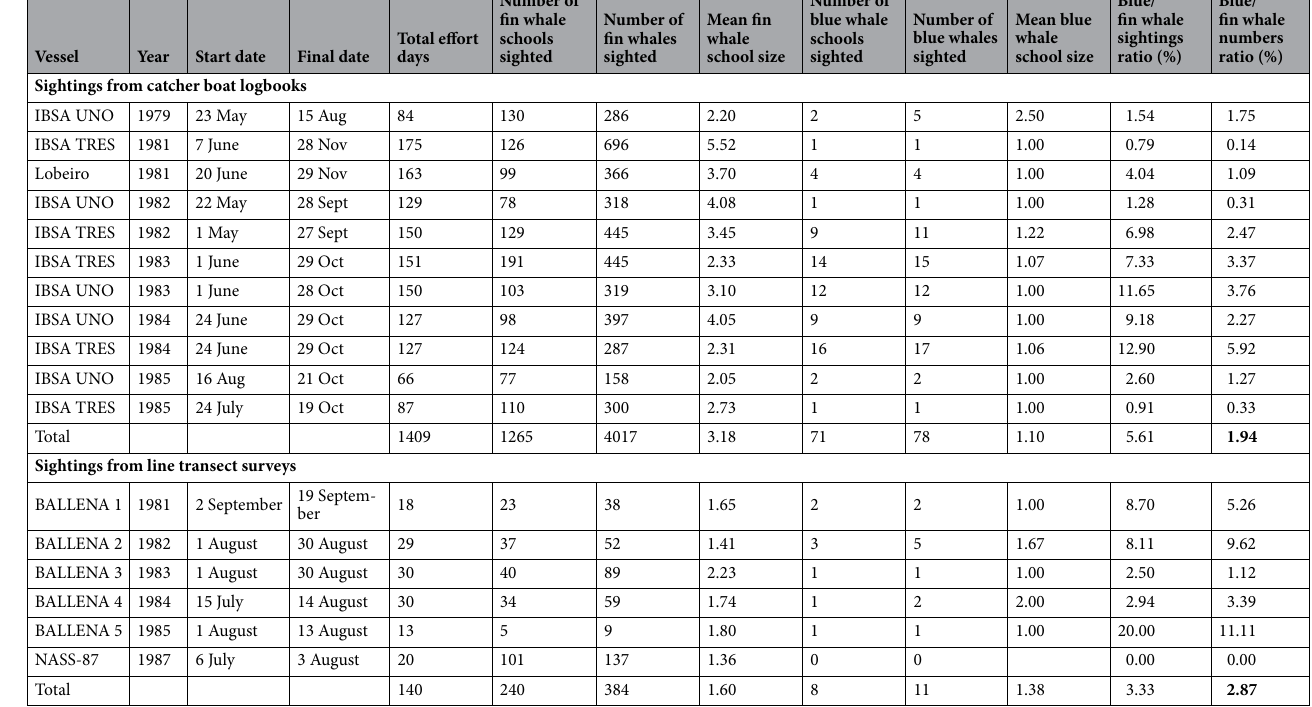
Table 1. Details of the IWC-type logbooks and the line transect surveys, with results of sightings, school size, and relative sighting rates (%) for fin and blue